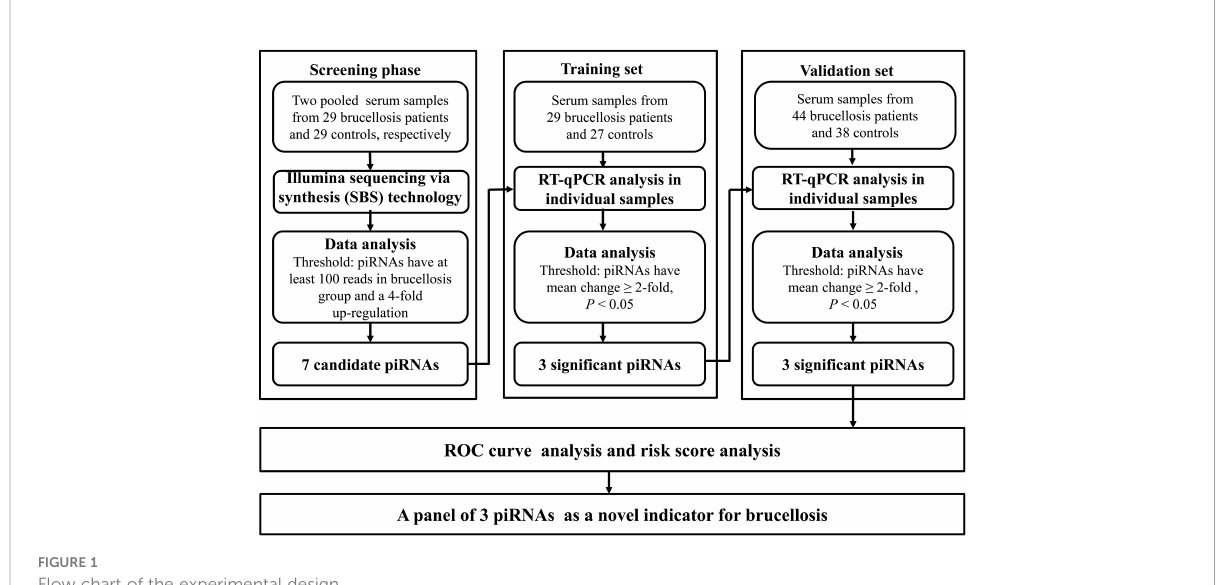
FIGURE 1 Flow chart of the experimental